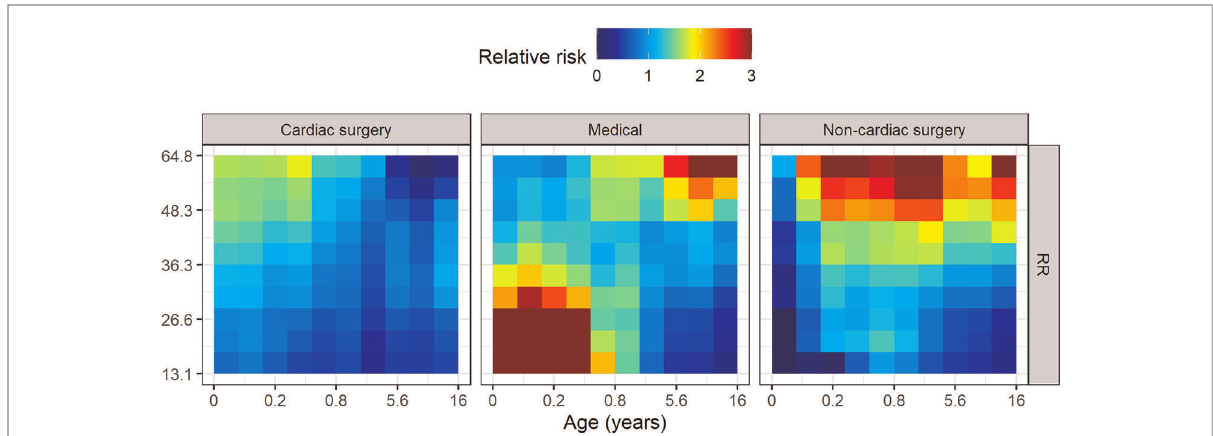
FIGURE 2 Empirical relative risk for cardiac surgery (left), medical (center), and non-cardiac surgery (right) patients as a function of age and mean respiratory rate from continuous monitoring data. On each panel, younger patients are to the left, and slower respiratory rates are to the bottom. Each colored tile estimates the relative risk of unplanned intubation for each decile of age and respiratory rate based on the surrounding quintile. Deciles of respiratory rate and age remain the same across patient type panels. Higher relative risk is redder while lower is bluer.